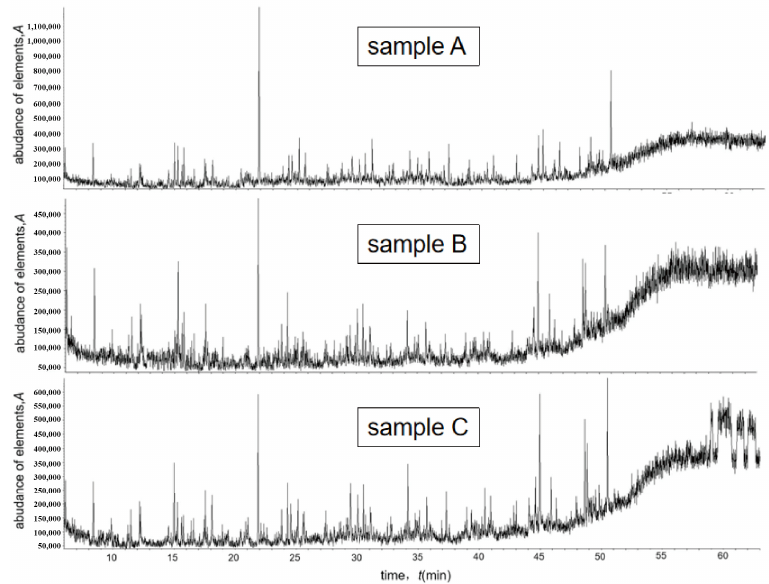
Figure 5. The total ion chromatogram of three tar samples.